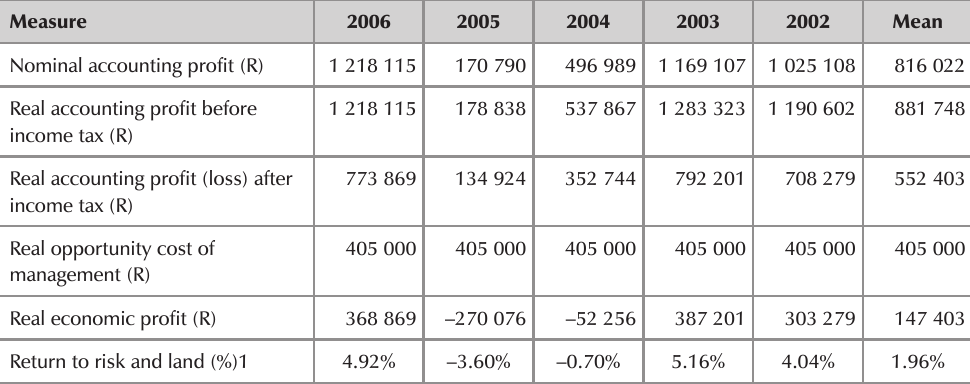
Key measures: Sugarcane and timber farm, Mtonjaneni municipality, KZN (2006=100) Measure